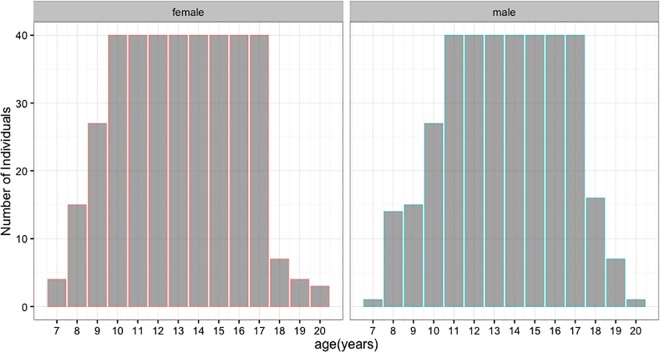
Age and sex distribution of the study sample.